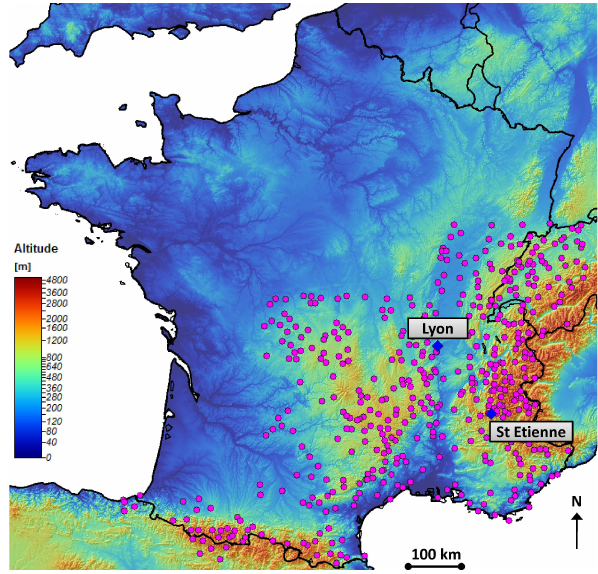
Fig. 1. Localisation of the 478 rain gauges used in this study (Lyon and St Etienne en D´evoluy rain gauges are